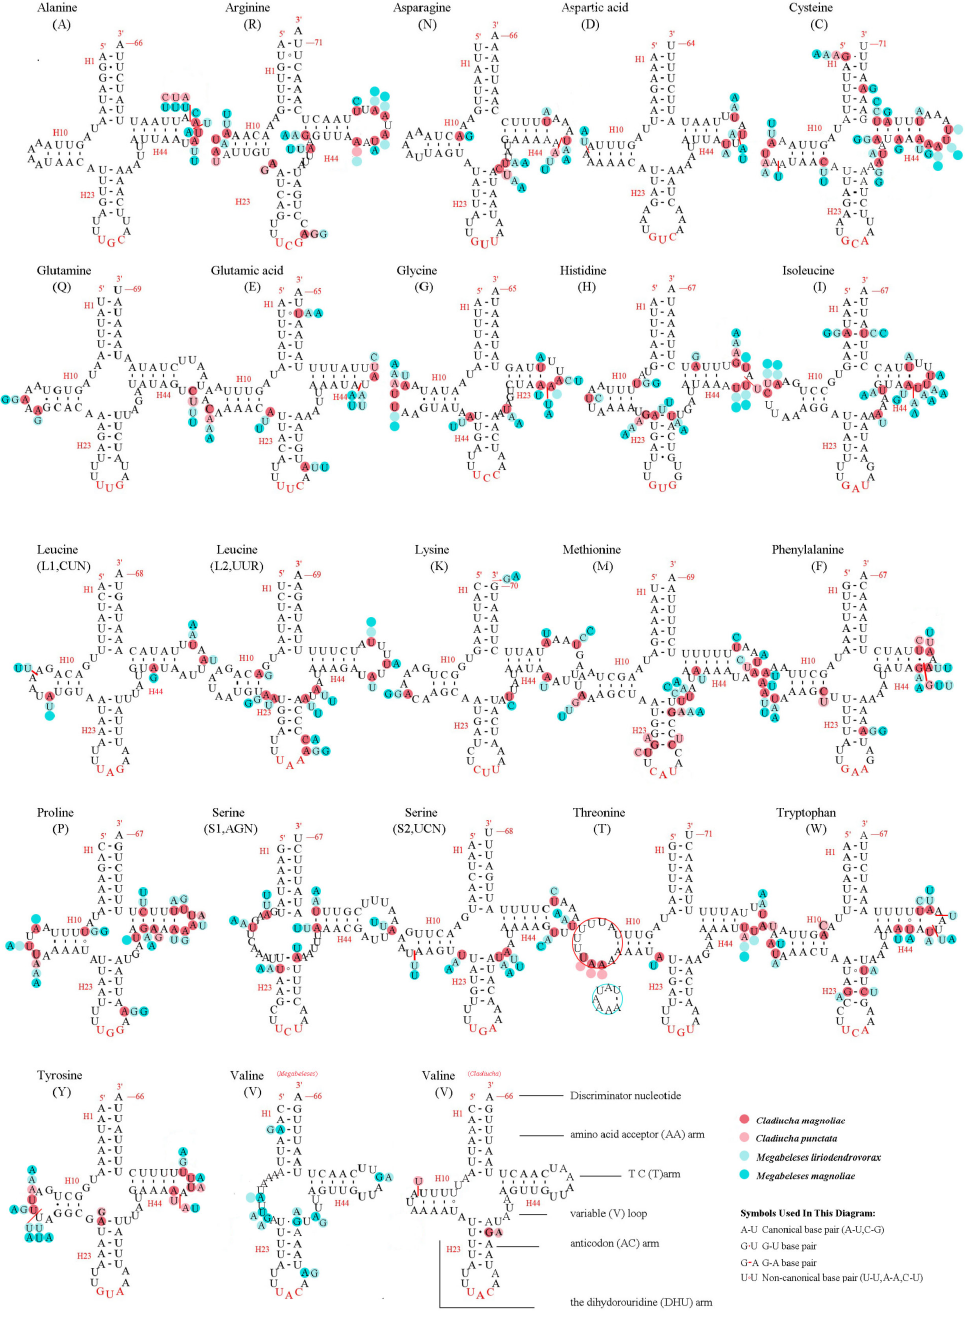
Figure 3. Predicted secondary structures of 22 tRNA genes of Cladiucha . Dashes indicate Watson-Crick base pairs, and dots indicate G-U base pairing.